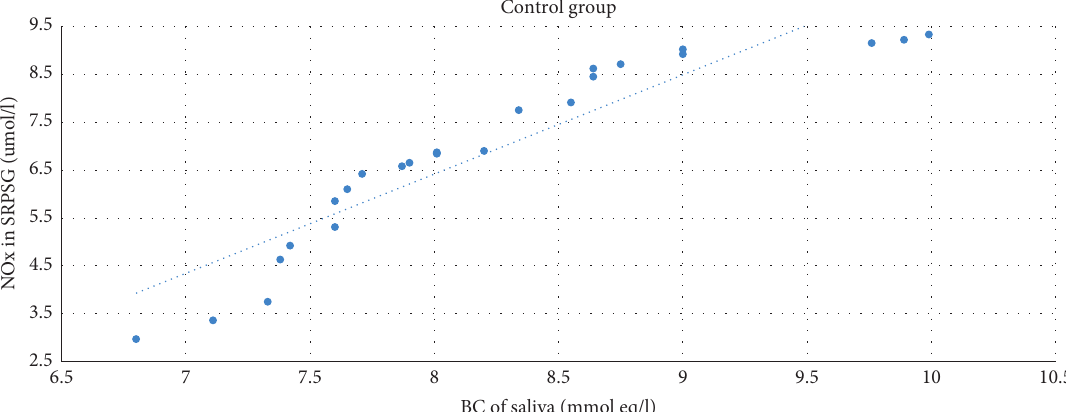
Figure 7: The correlation between the NOx level in SRPSG and the buffer capacity of saliva among patients in the control